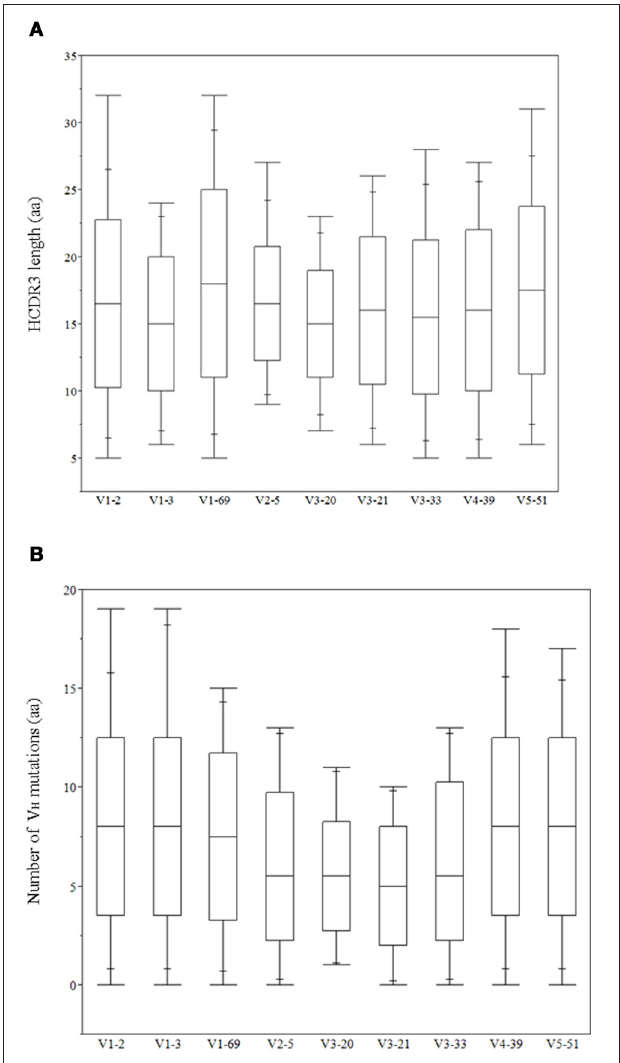
FIGURE 2 | Distribution of heavy chain complementarity determining region (HCDR3) lengths in (aa) (A) and V H mutations (aa) (B) of IGHV genes related to the antiviral